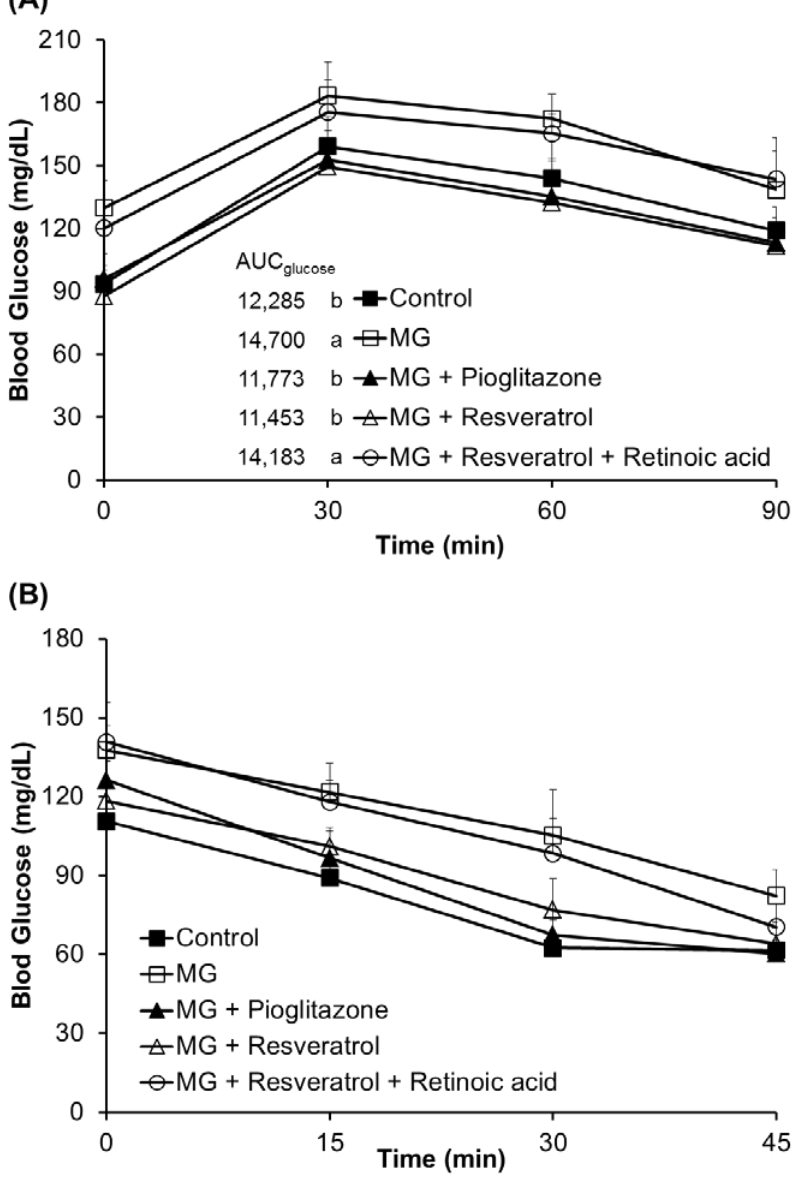
Figure 1. The effects of resveratrol on the ( A ) oral glucose tolerance test (OGTT) and the ( B ) insulin tolerance test (ITT). The data shown represent the mean ± SD ( n = 6). (a,b) indicate a statistically-significant difference at p < 0.05. MG: